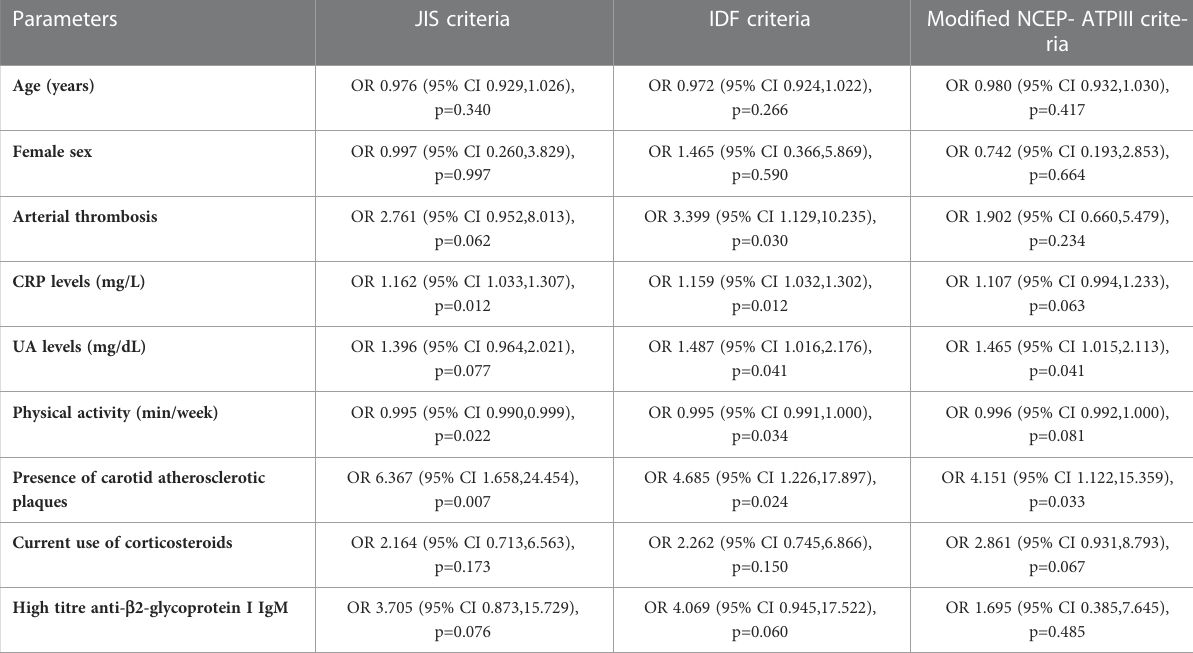
TABLE 4 Multivariate determinants for the presence of metabolic syndrome in APS patients based on JIS, IDF and modi fi ed NCEP-ATPIII criteria. Parameters JIS criteria IDF